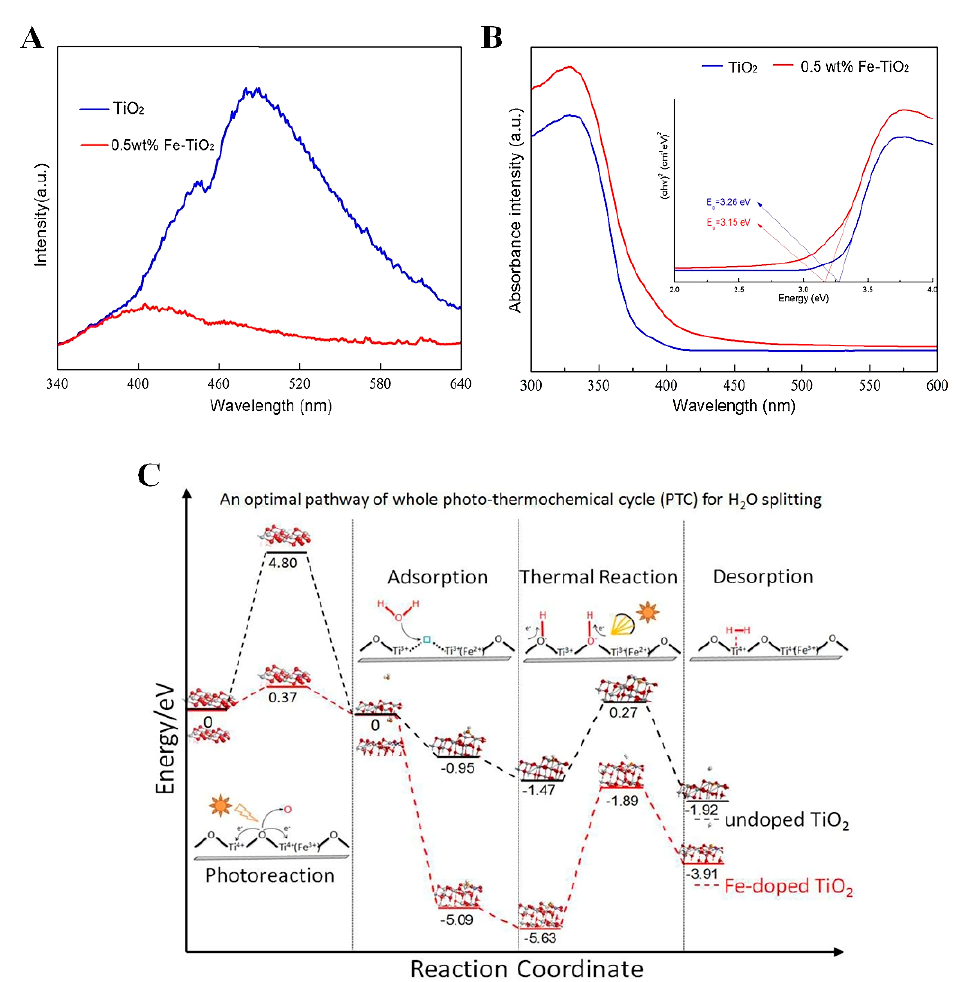
Figure 15. ( A ) PL profiles for TiO 2 and 0.5 wt% Fe-doped TiO 2 . ( B ) UV–vis DRS profiles for TiO 2 and 0.5 wt% Fe-doped TiO 2 . Inset shows the optical energy band gap. ( C ) The reaction pathway of H 2 O splitting during PTC process. Reprinted with permission from Ref. [163], copyright 2017, Elsevier.